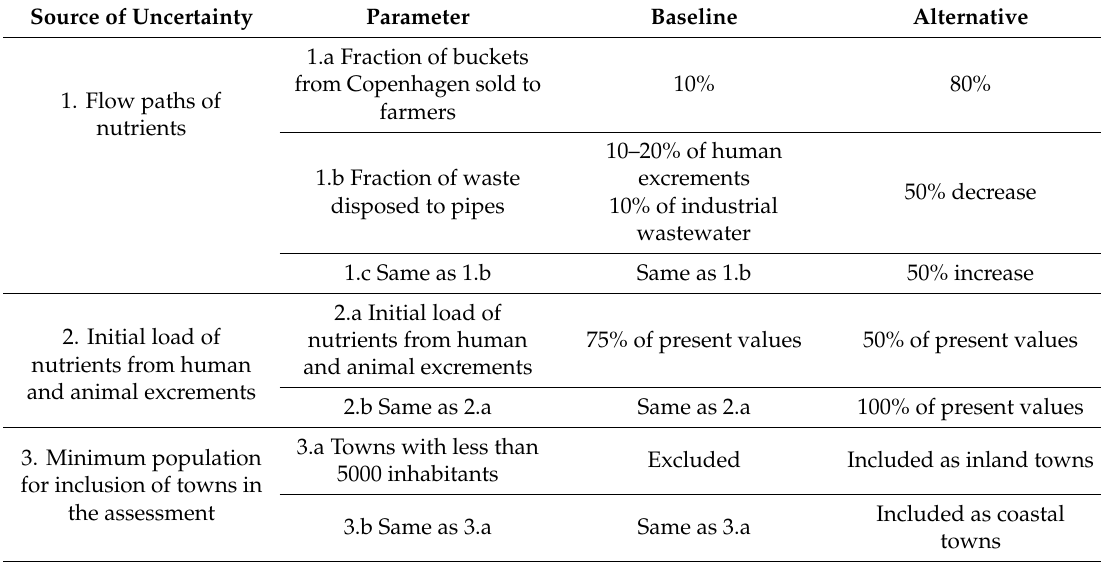
Table 2. Tested alternative scenarios for selected parameters, characterized by a high